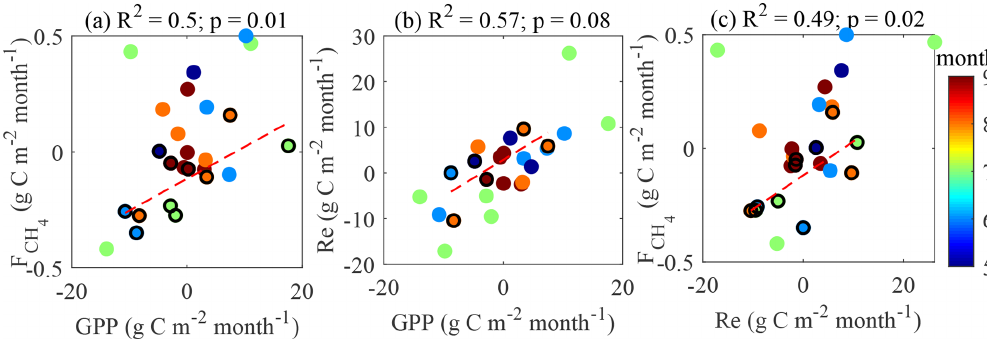
Figure B2. Same as Fig. B1, now for flux anomalies vs. flux